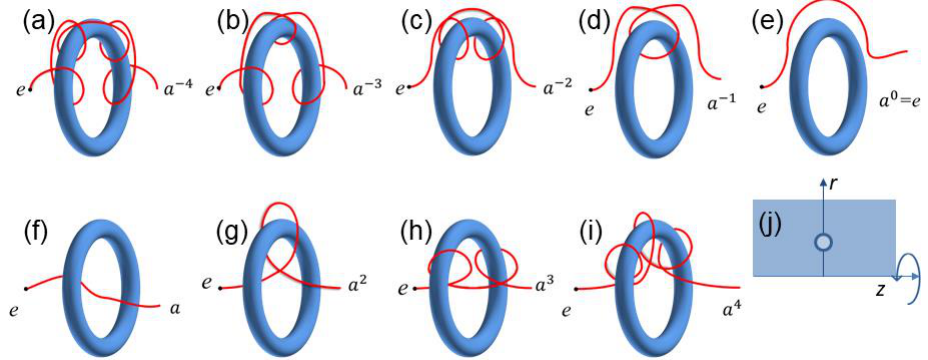
Figure 2. In evaluating the probability of the free end of an ideal chain being found in the subspace g , denoted by P g , we explore nine possible subspaces or nine entangling modes ( a – i ). Note that another end of the chain is fixed at point in the subspace e with e the identity element of the infinite cyclic group. ( j ) Illustration of the ( r , z ) coordinate employed in this work. The blue circle represents the cross-section of the ring. The axis z is the central axis of the ring.